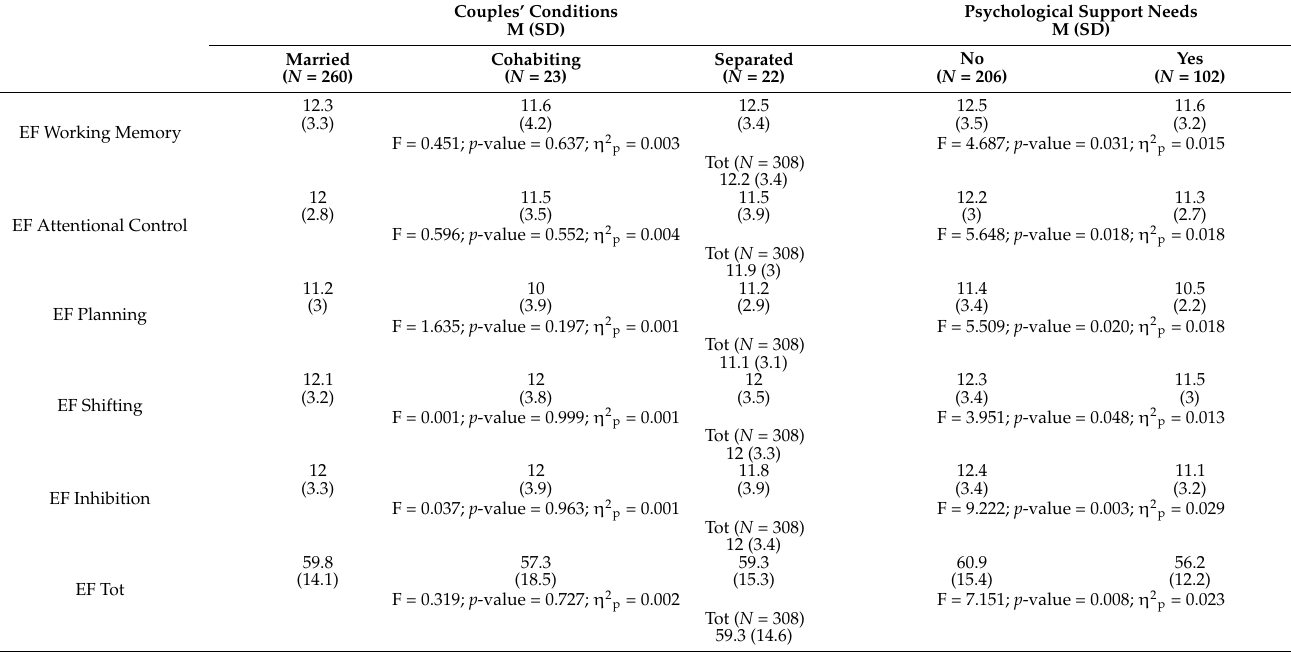
Table 10. EF descriptive data and ANOVA analyses for couples’ conditions and psychological support